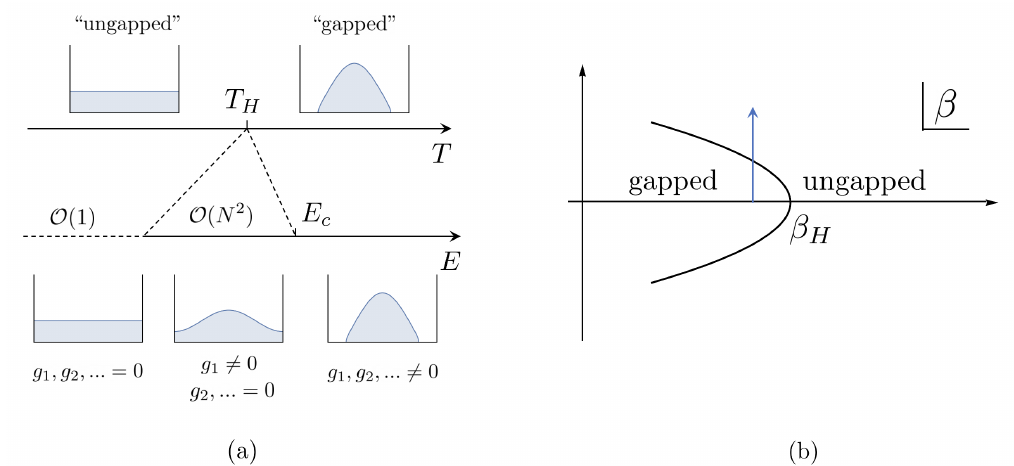
Figure 4 . (a) The phase structure in the canonical ensemble (top) and the microcaonincal ensemble (down) at t = 0 . (b) If we consider the quantity Z ( β + it ) and increase t (along the blue arrow), we will soon encounter a phase transition and go into the ungapped